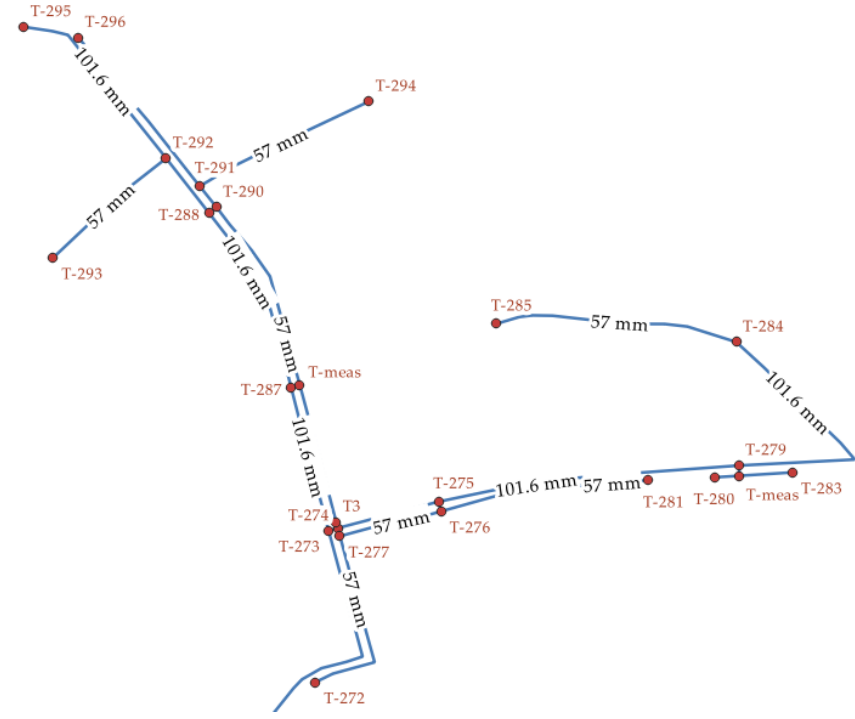
Figure 5. Hydraulic model structure overview with hydraulic pipe diameter.